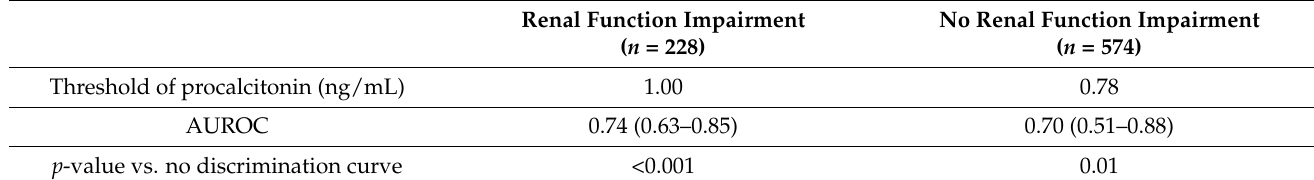
Figure 3. Comparison of the receiver-operating characteristic (ROC) curves in determining the predictive value of procalcitonin for the diagnosis of postoperative infection in patients without or with postoperative renal dysfunction. Table 6. Comparison of the AUROC of procalcitonin for the diagnosis of postoperative infection according to postoperative renal function.